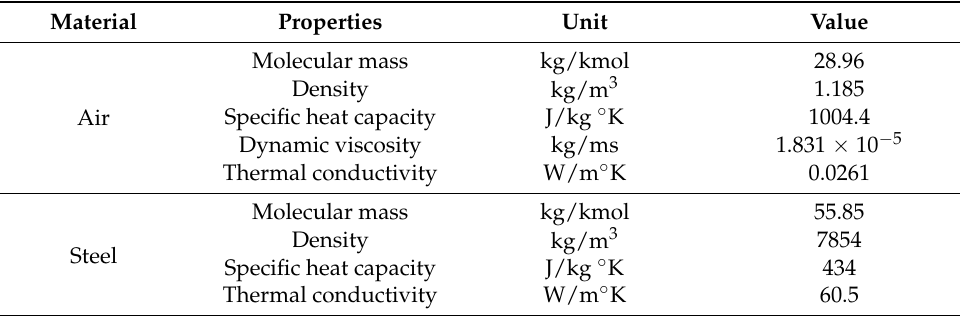
Table 1. Material properties (for simulation).